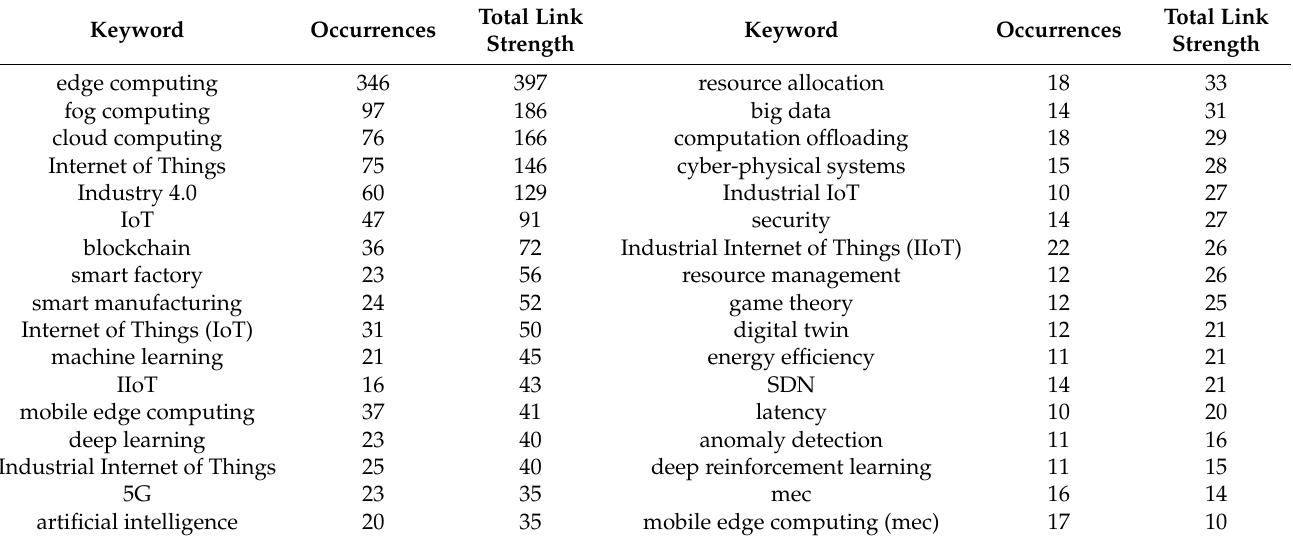
Table 2. An initial list of terms with a threshold of 10